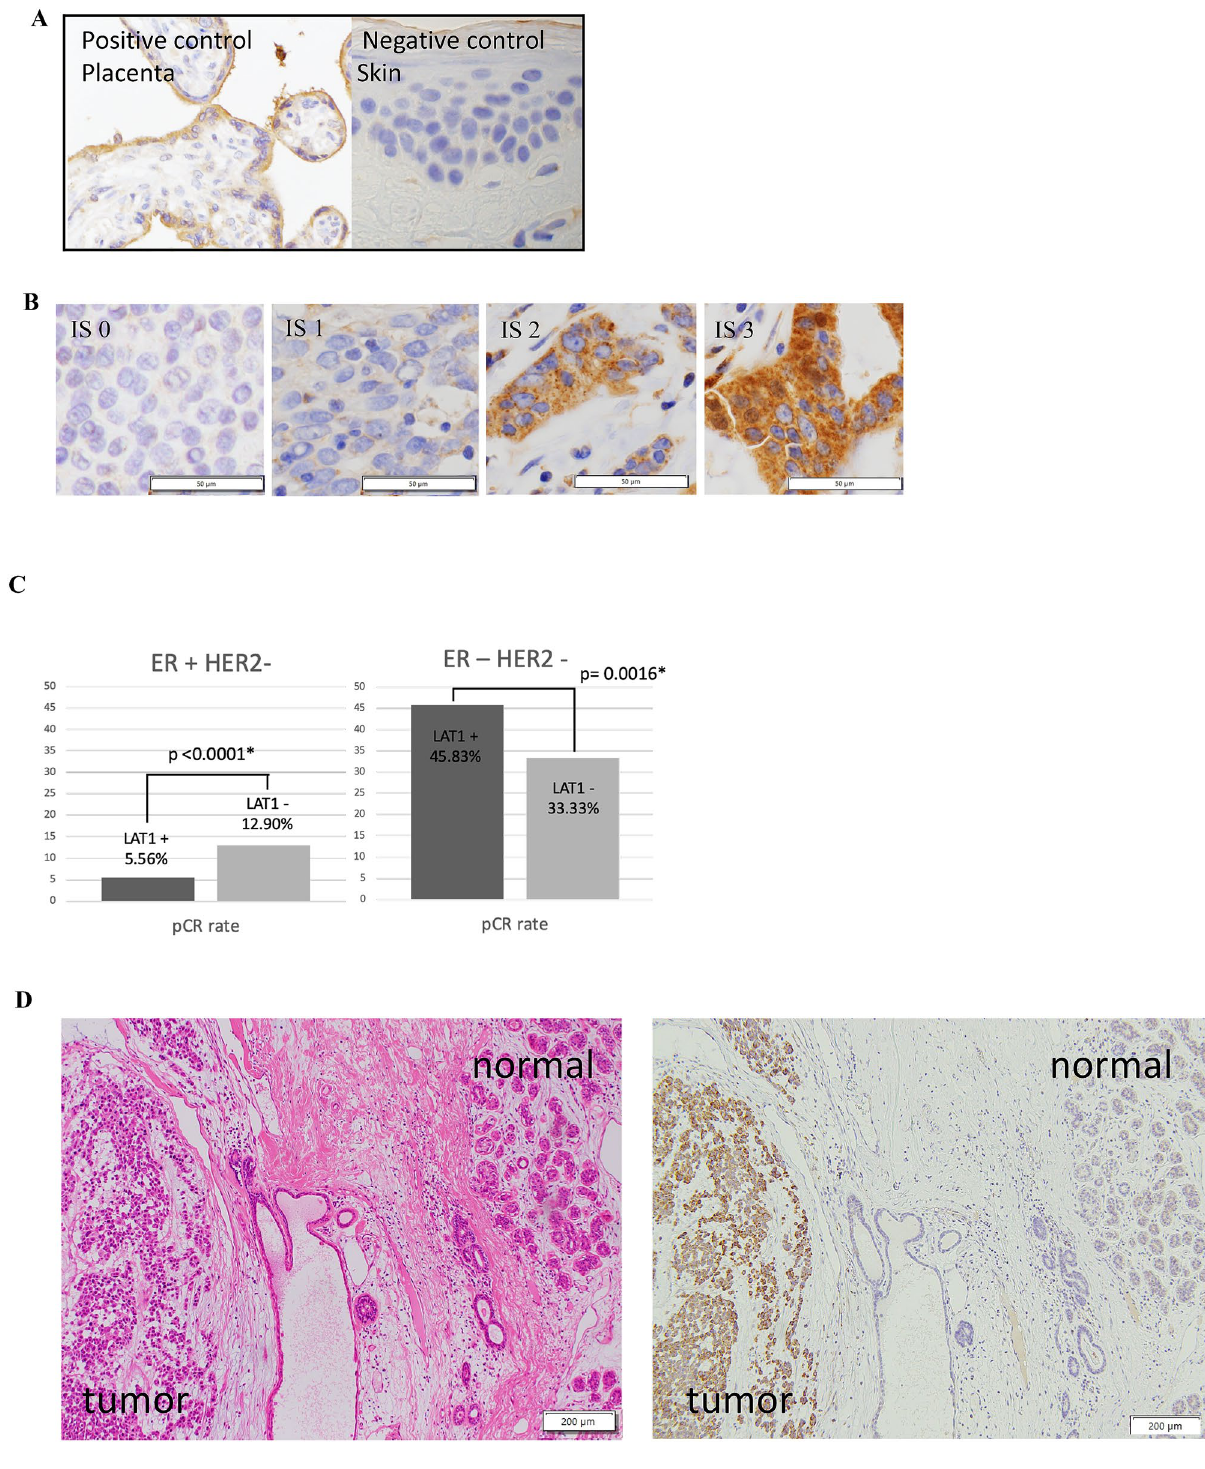
Figure 1. Immunohistochemistry for LAT1. Human placenta and skin tissue were used as positive and negative control ( A ). Immunohistochemical staining of LAT1. Intensity were scored from 0 to 3 (0: no membranous staining, 1: low intensity, 2: weak to moderate complete intensity, 3: high intensity). The subtype of these tissues are Luminal type. Expression was observed in the cytoplasm and cell membrane (B ). Pathological response rate of LAT1 positive or negative in ER + HER2- or ER-HER2- breast cancer patients with neo adjuvant chemotherapy. P < 0.0001 for pCR rate in ER + HER2- patients, P = 0.0016 for pCR in ER-HER2-patients. Pre LAT1 total score of 14 or more was positive. The cutoffs for positive was defined as ROC curve of CMR or non- CMR (C ). LAT1 was highly expressed in breast carcinoma cells but not in adjacent normal or non-neoplastic breast tissues (D ) . The subtype of this tissue is triple